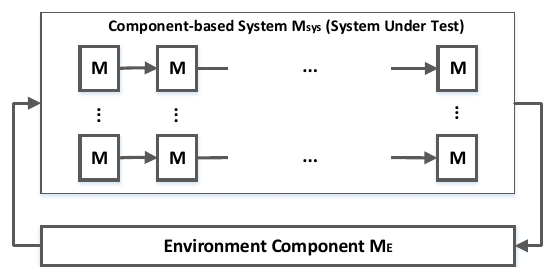
Fig. 6. System configuration used to conduct the experi- ments ( M - component, M E - environment